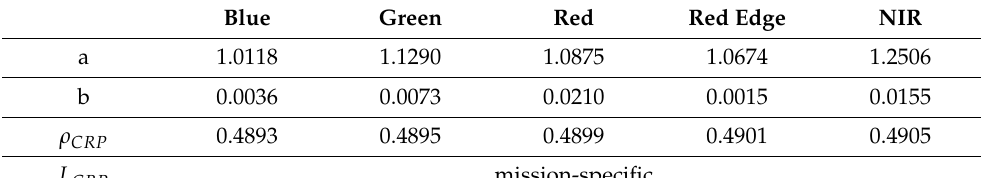
Table 3. Coefficients used to extract the correction factors of the five RedEdge-M